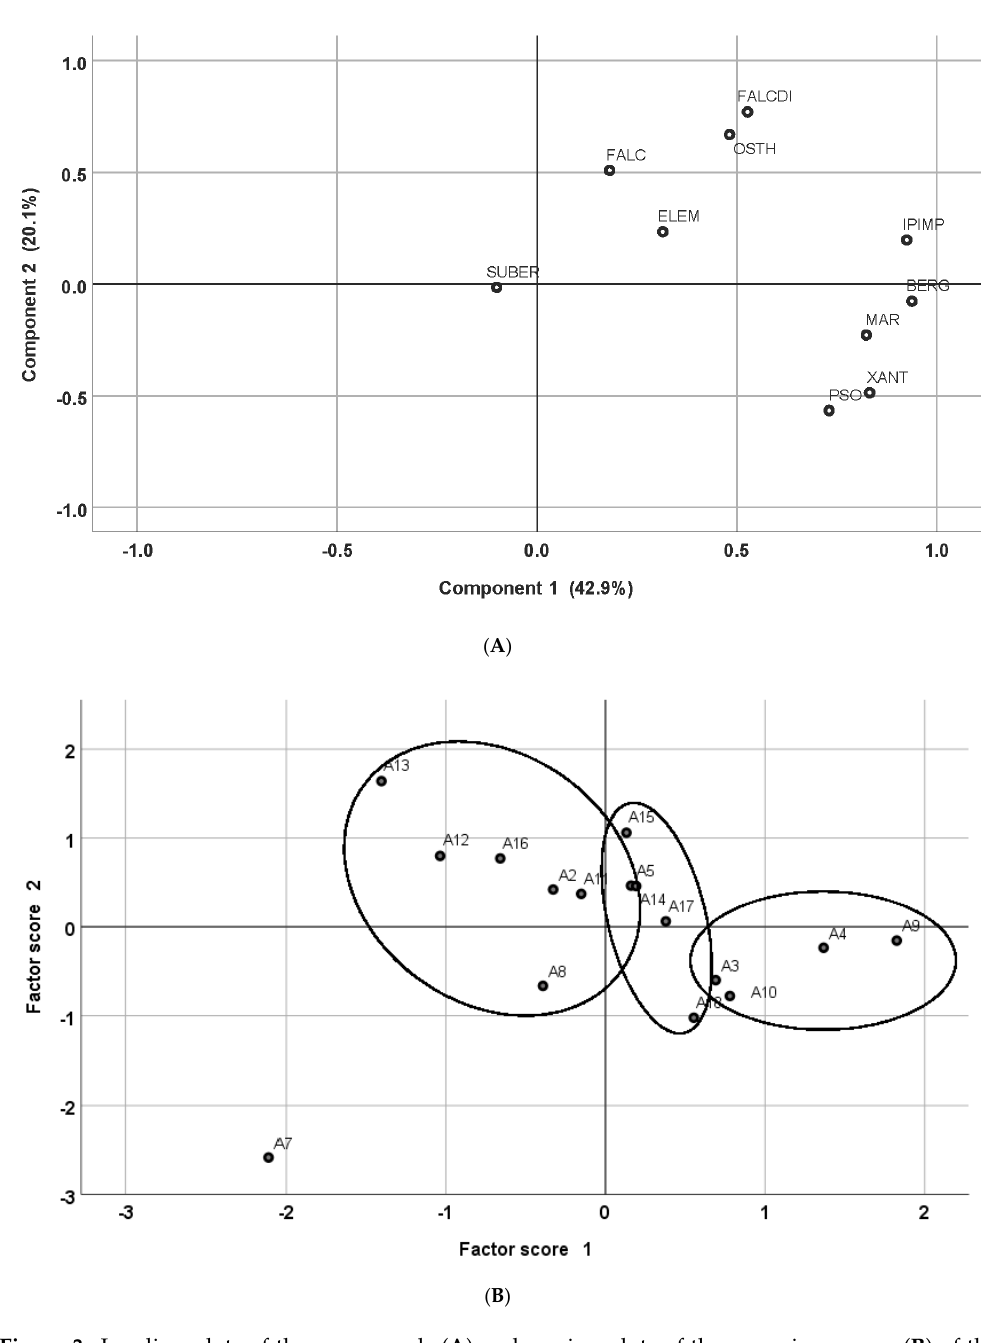
Figure 3. Loading plots of the compounds ( A ) and scoring plots of the accession means ( B ) of the first two components in principal component analysis (PCA). BERG: bergapten, ELE: elemicin, FALC: falcarinol, FALCDI: falcarindiol, IPIMP: isopimpinellin, MAR: marmesin, OST: osthol, PSO: psoralen, SUBER: suberenol, XANT: